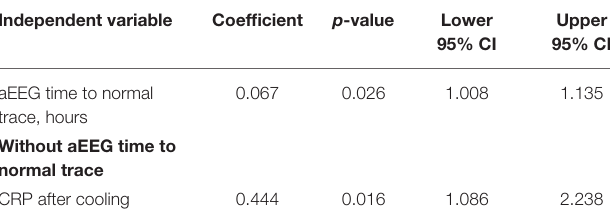
TABLE 3 | Results of multivariate analysis using binary logistic